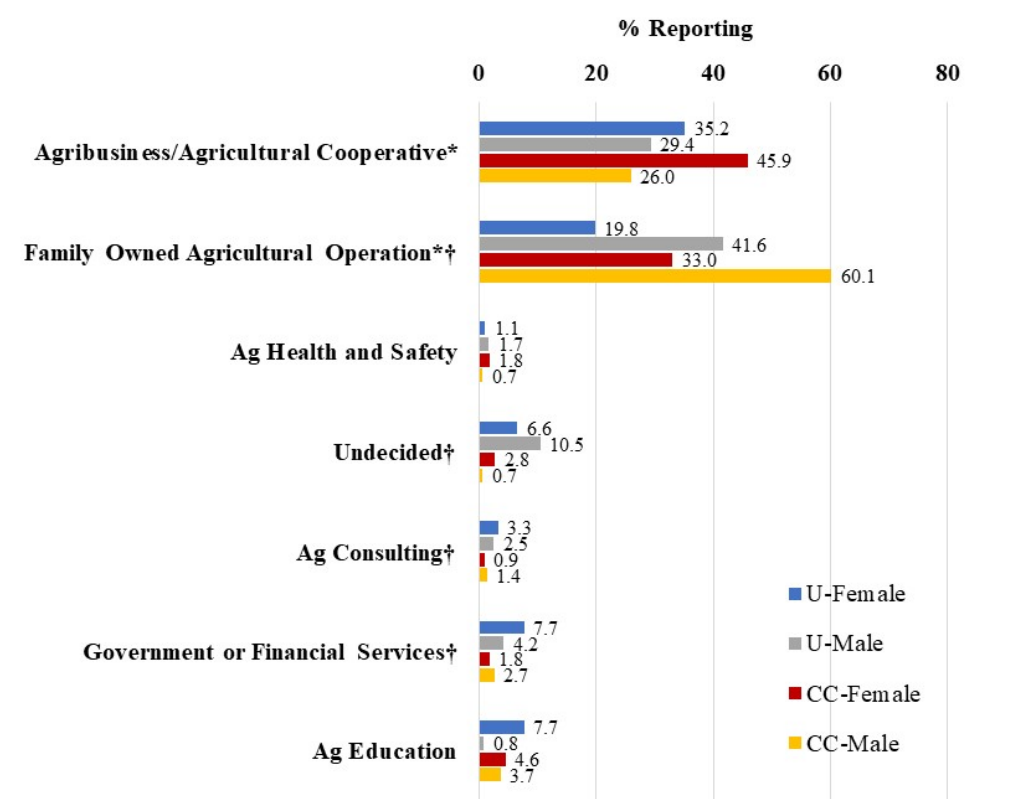
Figure 4. Proportion of participants reporting agricultural career path following graduation. Note: U-Female = University female; U-Male = University male; CC-Female = Community College Female; CC-Male = Community College Male. * Indicates differences between male and female responses, using a 2 proportions Z-test ( p ≤ 0.05) † Indicates differences between university and community college responses, using a 2 proportions Z-test ( p ≤ 0.05).